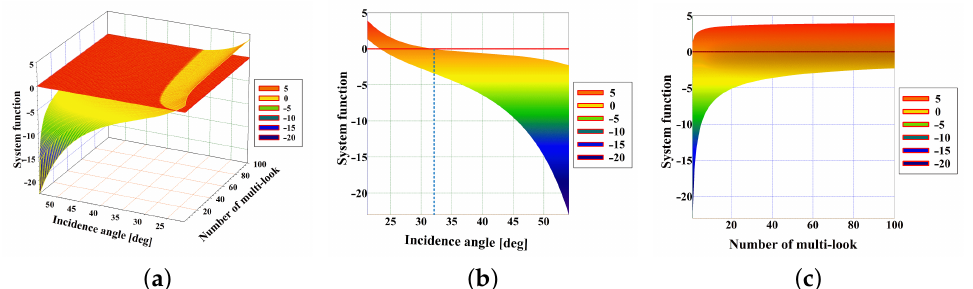
Figure 3. ( a ) The SAR system function varies with the incidence angle φ and the number of multi-looks L look when the average transmitting power and satellite height are P av = 100,000 W and H sat = 100 km. ( b , c ) are the simulation results of the system function changing with φ and L look , separately.